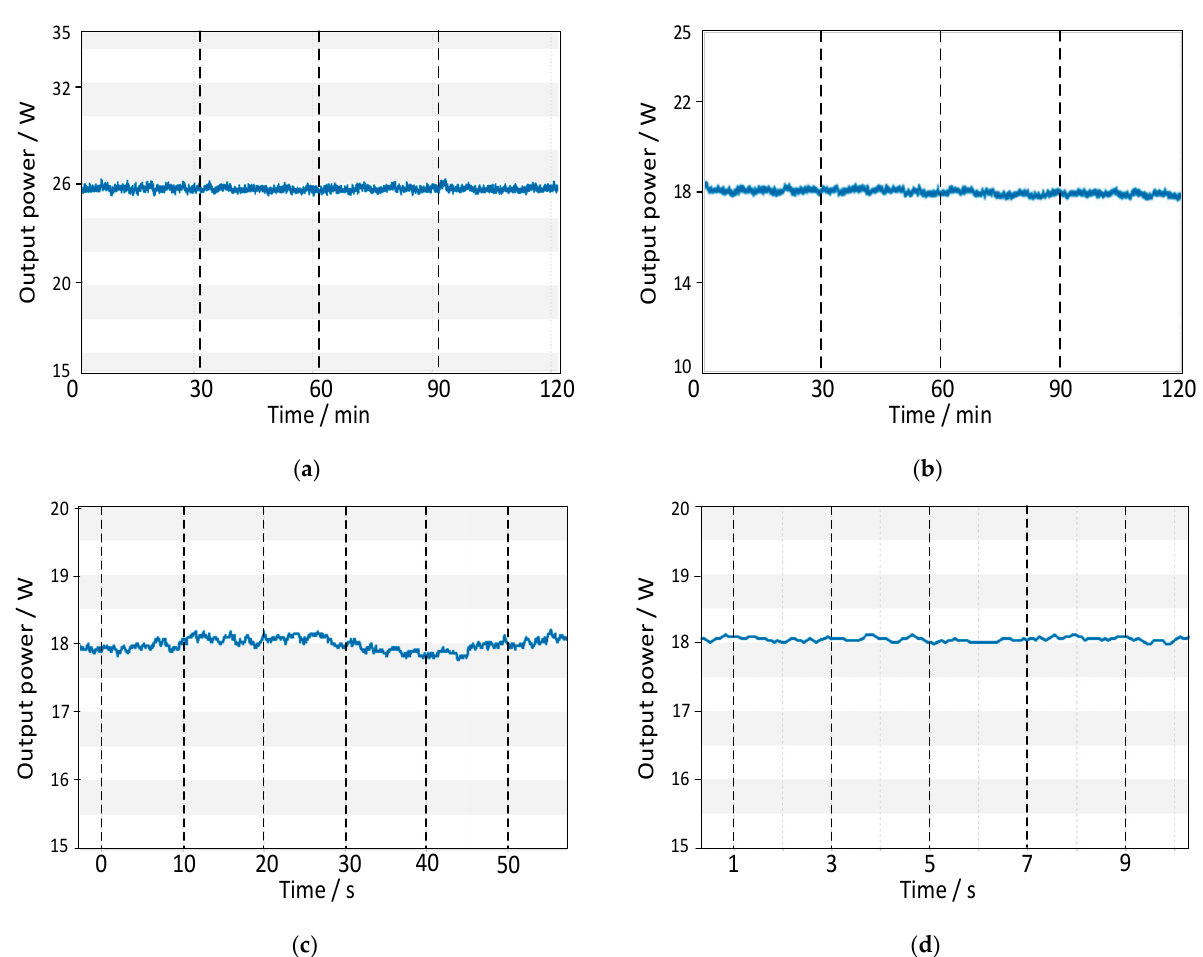
power is 18.03 mW of the QML operation state, according to the results of Figure 10b. Figure 9. Average energy of single mode − locked pulse versus the pump at CWML and QML oper- operation state.